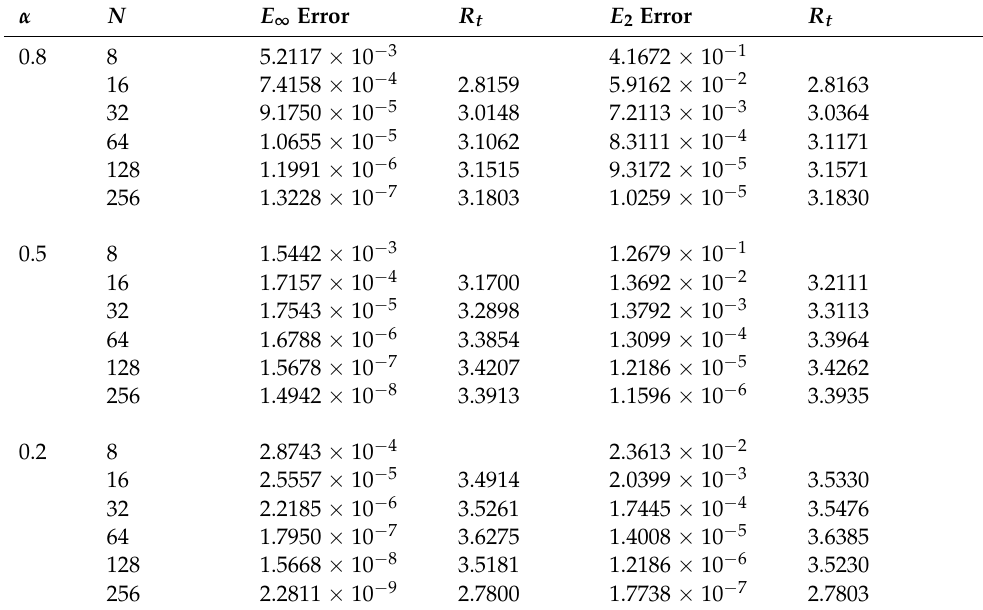
Table 8. Errors E ∞ and E 2 with convergence rates in time for Example 3, when h = 1/12000 with different α s.